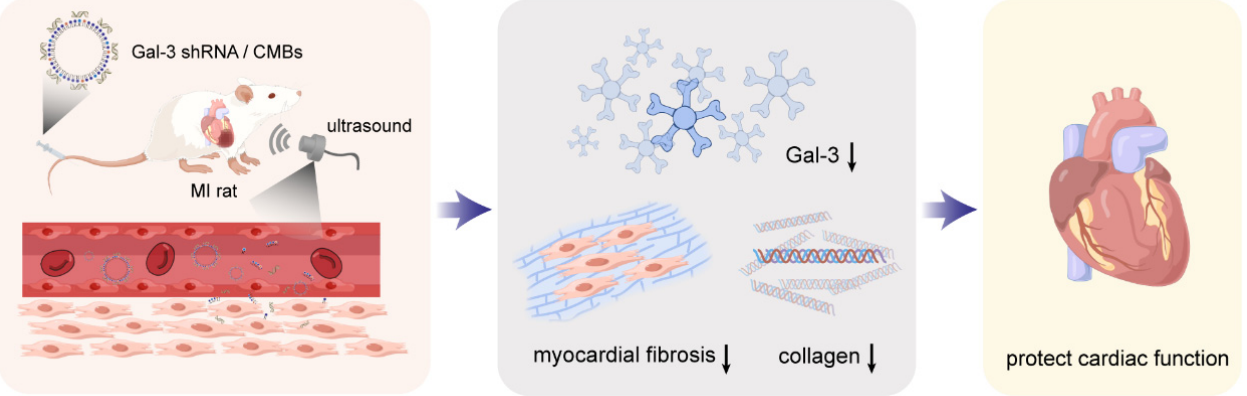
Figure 1. Schematic representation of Gal-3 shRNA delivery mediated cardiac function protection. The arrow represents downregulation (This figure was drawn by Figdraw).